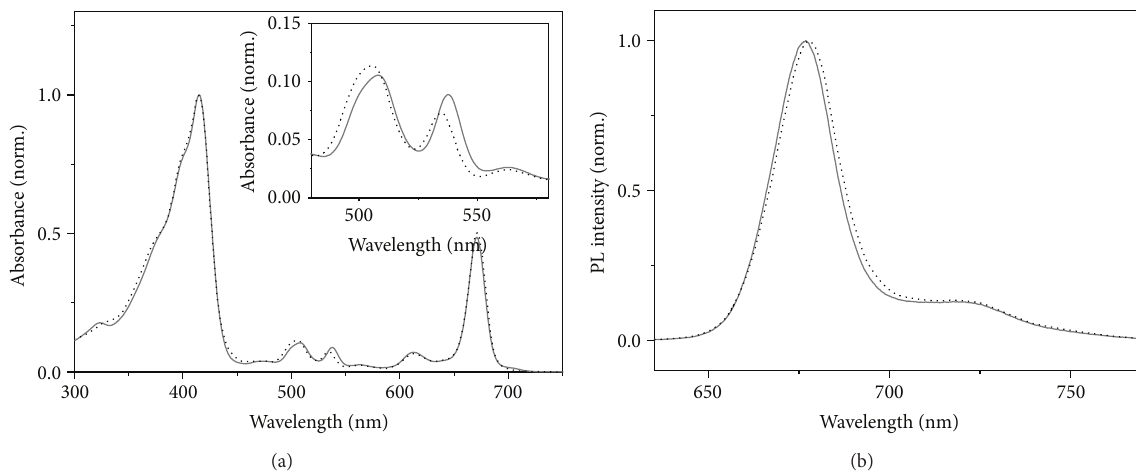
Figure 2: (a) Steady-state absorption spectra of PaDs. The details of 𝑄 𝑥 -bands are shown in the inset. (b) Steady-state fluorescence ( 𝜆 507 nm) spectra of PaDs in toluene solution; PA (solid grey line) and HPA (dotted black line).